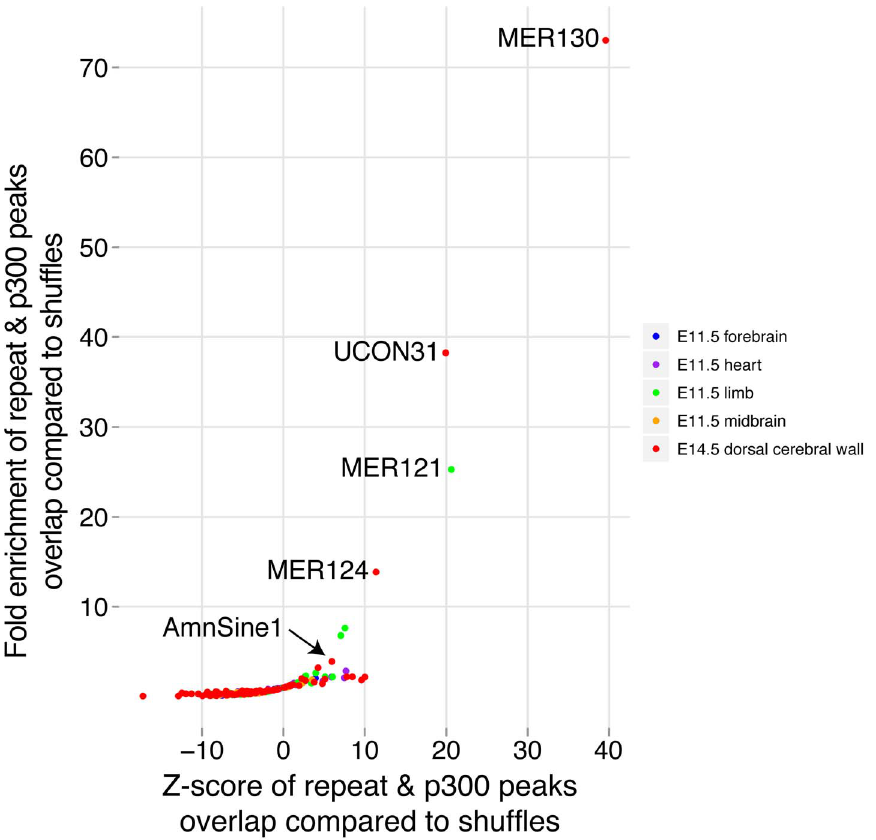
Figure 6. Co-option of mobile elements as dorsal cerebral wall enhancers. Each p300 ChIP-seq set was overlapped with all interspersed repeat families. For each combination, the expected number of overlaps was determined using 10,000 simulations where the p300 set was randomly distributed across the genome and overlaps were counted.